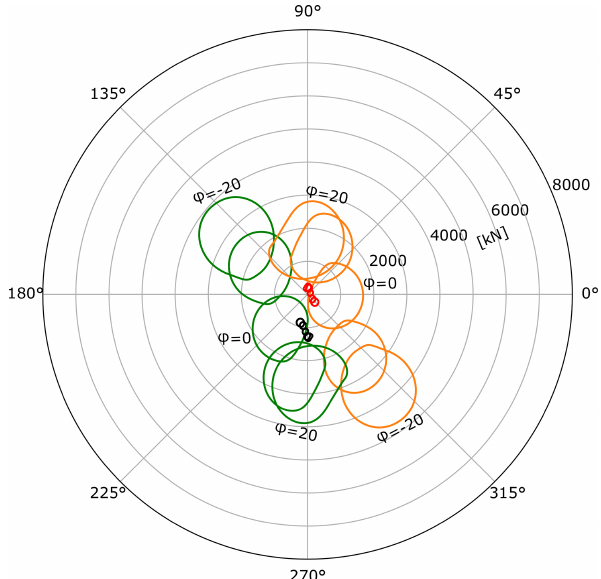
Figure 5. Bearing row radial force response patterns (for the 5MW model) under various values of yaw offset ( ϕ ) with a reference- height mean wind speed of 16ms − 1 . Overhung support results for upwind and downwind rows are orange and green, and centred sup- port results for upwind and downwind rows are red and black, re- spectively. As described in the opening paragraph of Sect. 4, force results are aligned with the true direction of applied force when viewing the turbine from upwind. For example, an applied force acting vertically downwards corresponds to an angle of 270 ◦ in the above plot.